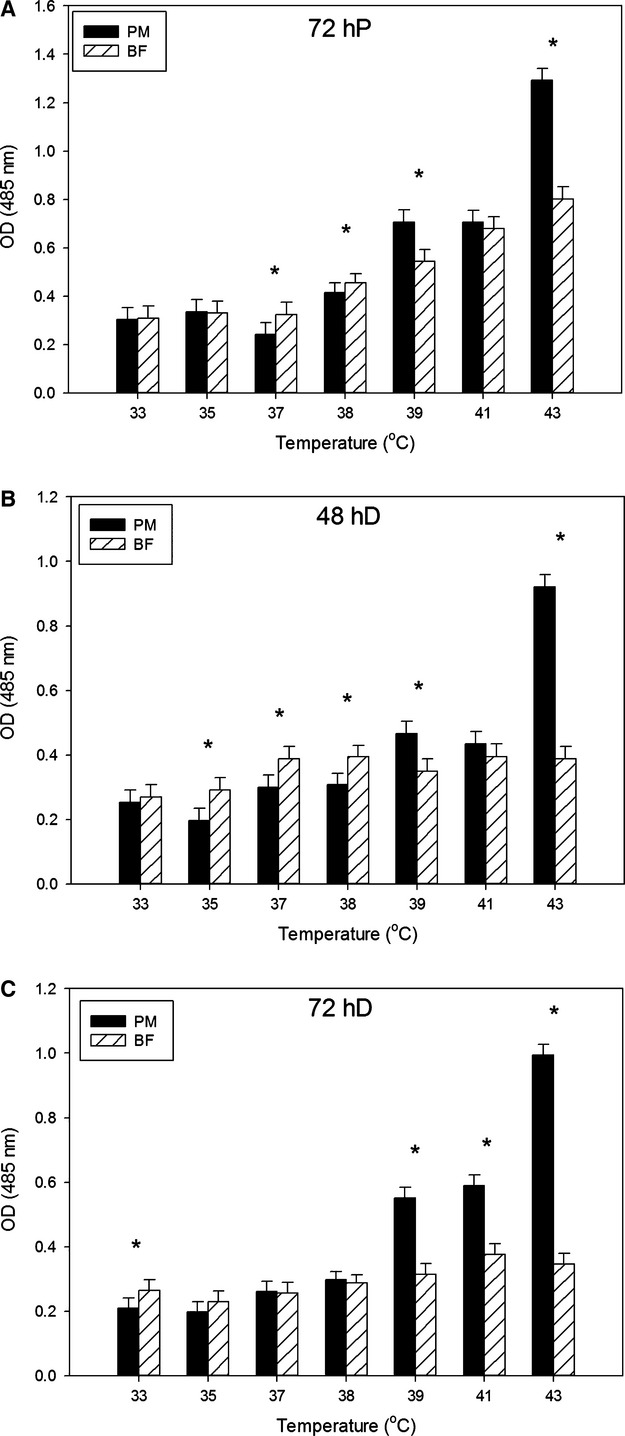
Analysis of the effect of temperature on lipid accumulation in pectoralis major and biceps femoris satellite cells during proliferation and differentiation. AdipoRed fluorescence as a measure of lipid accumulation in satellite cells incubated between 33°C and 43°C analyzed at 72 h of proliferation (A), 48 h of differentiation (B), and 72 h of differentiation (C). Bars represent standard error of the mean. PM, pectoralis major; BF, biceps femoris. Data with *indicate significant difference between cell types (P ≤ 0.05).